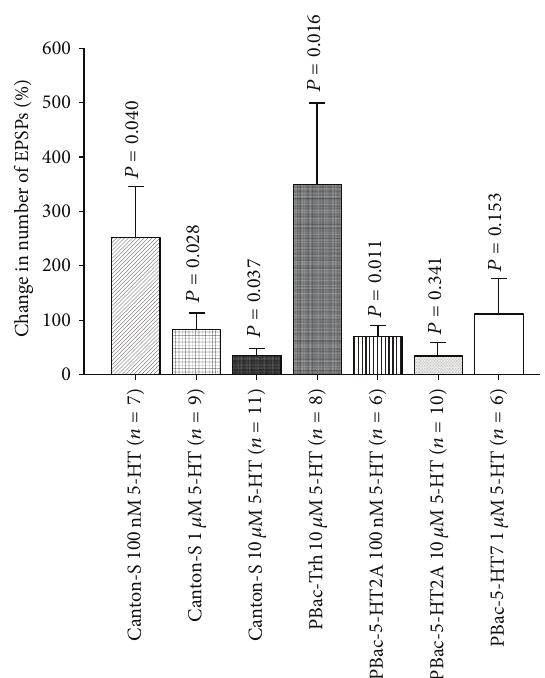
Figure 14: Effect in sensitivity to 5-HT modulation in line with disrupted aspects within the 5-HTergic system. 5-HT application on tryptophan hydroxylase (Trh) mutant third-instar larvae markedly increased sensory-motor circuit physiology. 5-HT at 10 𝜇 M expo- sure in CS third-instar larvae seems to desensitize 5-HT receptors since it does not markedly modulate neural circuitry in comparison to 5-HT 100nM. 5-HT2A receptor mutation significantly reduced the modulatory action of 5-HT. However, mutation in 5-HT7 receptor noticeably responds to 5-HT at 1 𝜇 M. Paired 𝑡 -test was used to compare the number of EPSPs in saline with saline that contained 5-HT. Data represented as mean ± SEM. 𝑃 < 0.05 is